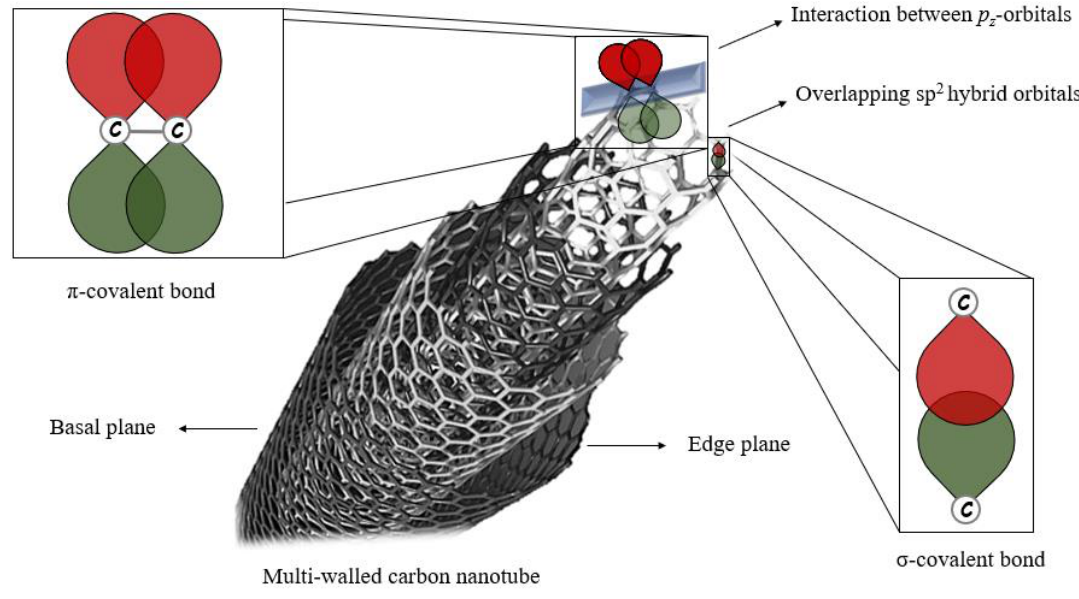
Figure 1. Representative structure of non-continuous multi-walled carbon nanotubes, emphasizing the different types of orbital interactions, as well as σ- and π-covalent bonds established along the 1D carbon networks.